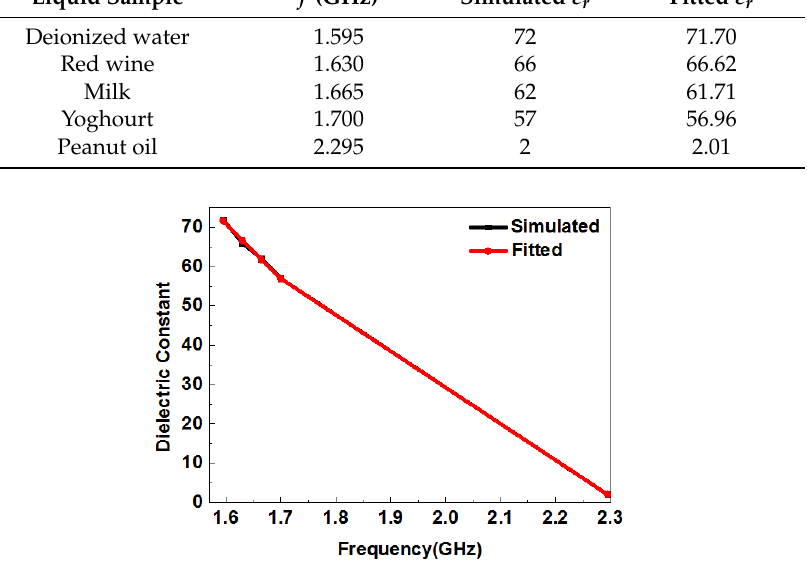
Figure 13. Simulated and fitted curve of the resonant frequencies of different liquids and their dielectric constants.